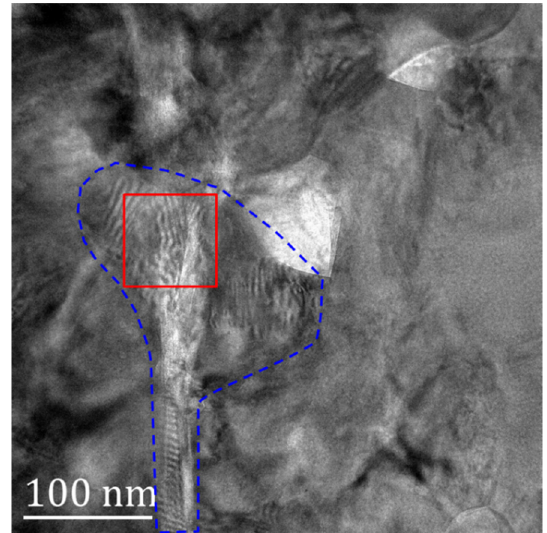
Figure 11. TEM image of TGO.